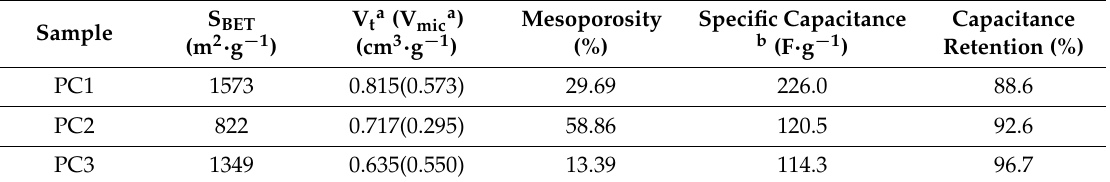
Table 1. Structure parameters of carbon samples and their capacitive performance.